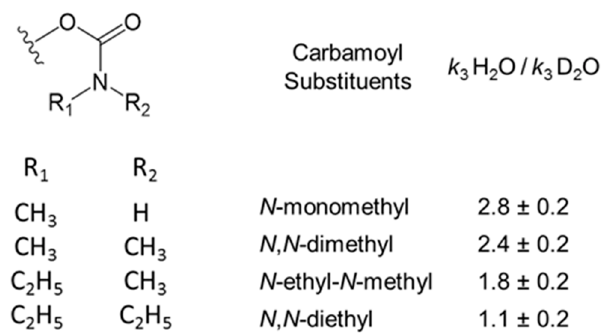
Figure 6. Solvent D 2 O isotope effects on the AChE decarbamoylation rate constant k 3 at 25 °C [2].